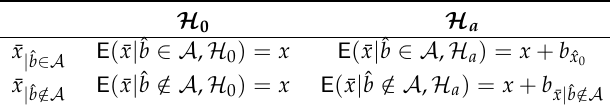
Table 2. The conditional means of ¯ x under H 0 and H a